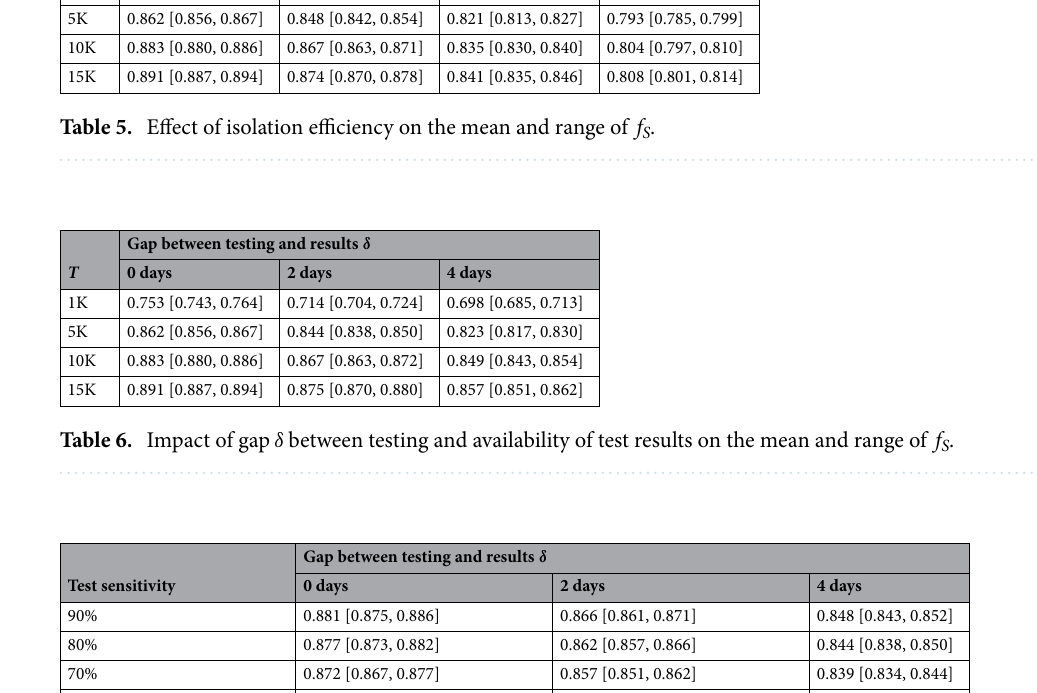
Table 7. Impact of the rate of false negatives together with the the gap between testing and availability of test results on the mean and range of f S with T = 10K daily tests.